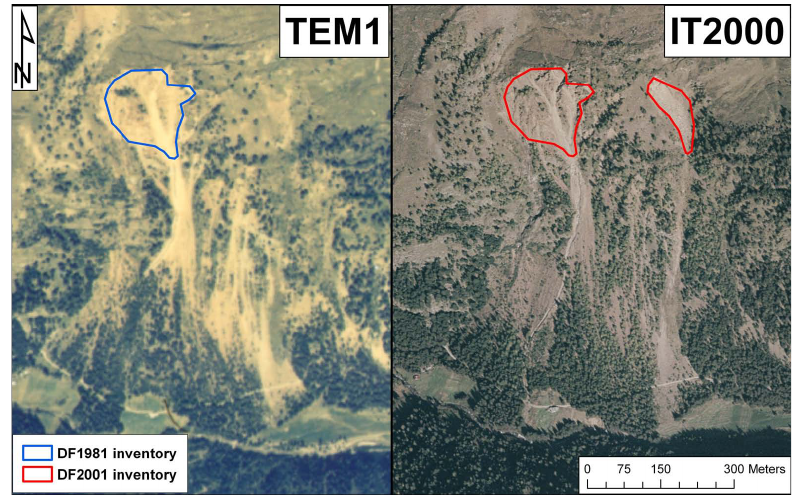
Fig. 4. Example showing the difference between DF1981 and DF2001 inventories, that were used to calculate the temporal probability (frequency) of debris flow initiation. On the left the orthorectified aerial photograph from 1981 (flight TEM1), on the right the orthophoto from 2001 (flight IT2000). Debris flow activity (new scarp) is visible on the photo from 2001, while on the photo taken in 1981 this scarp is missing.